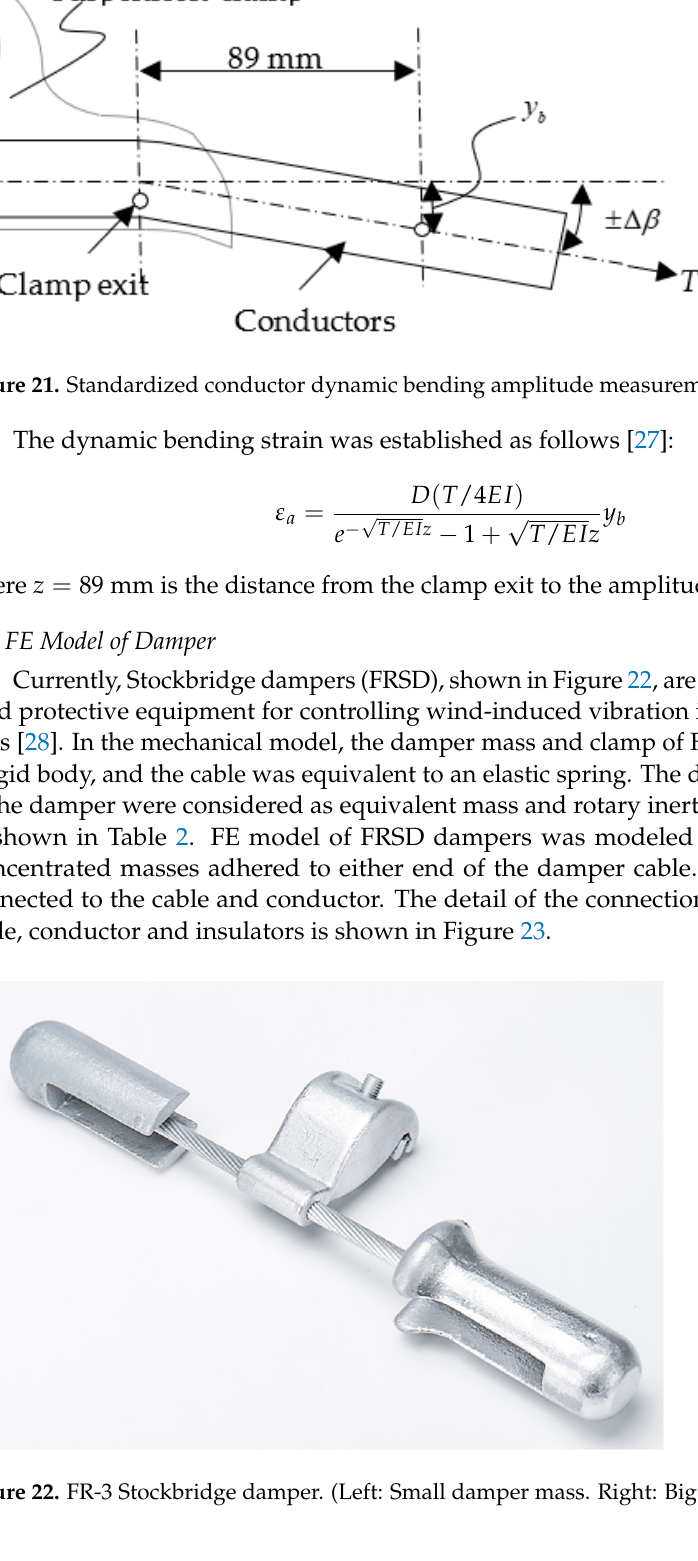
Figure 23. Detail of FE model of FRSD damper. Table 2. Structure parameters of FRSD. Substructures